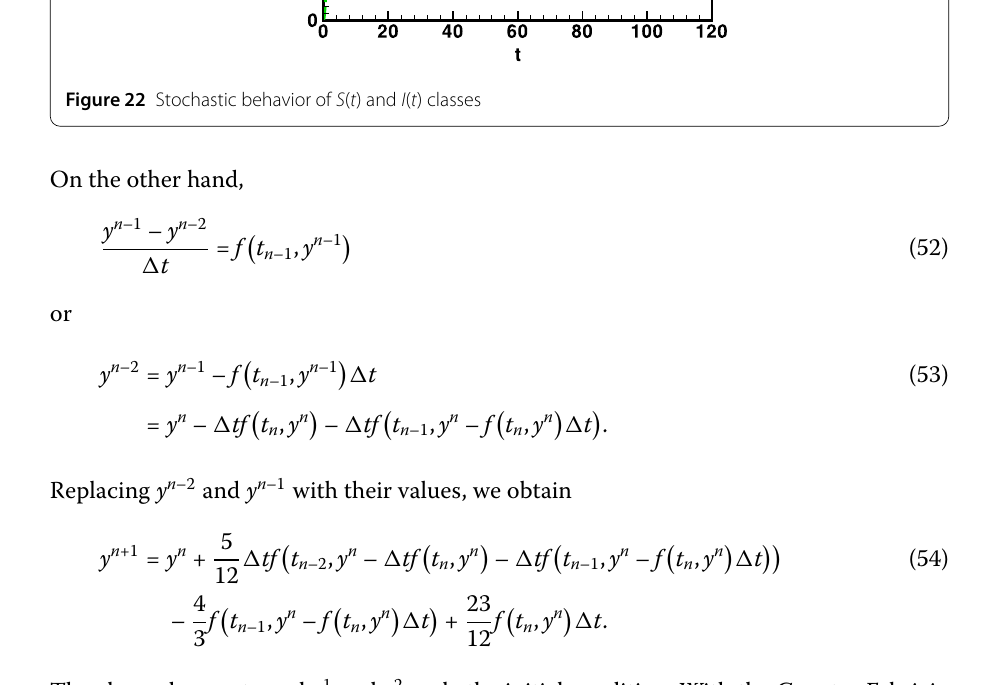
Figure 22 Stochastic behavior of S ( t ) and I ( t ) classes